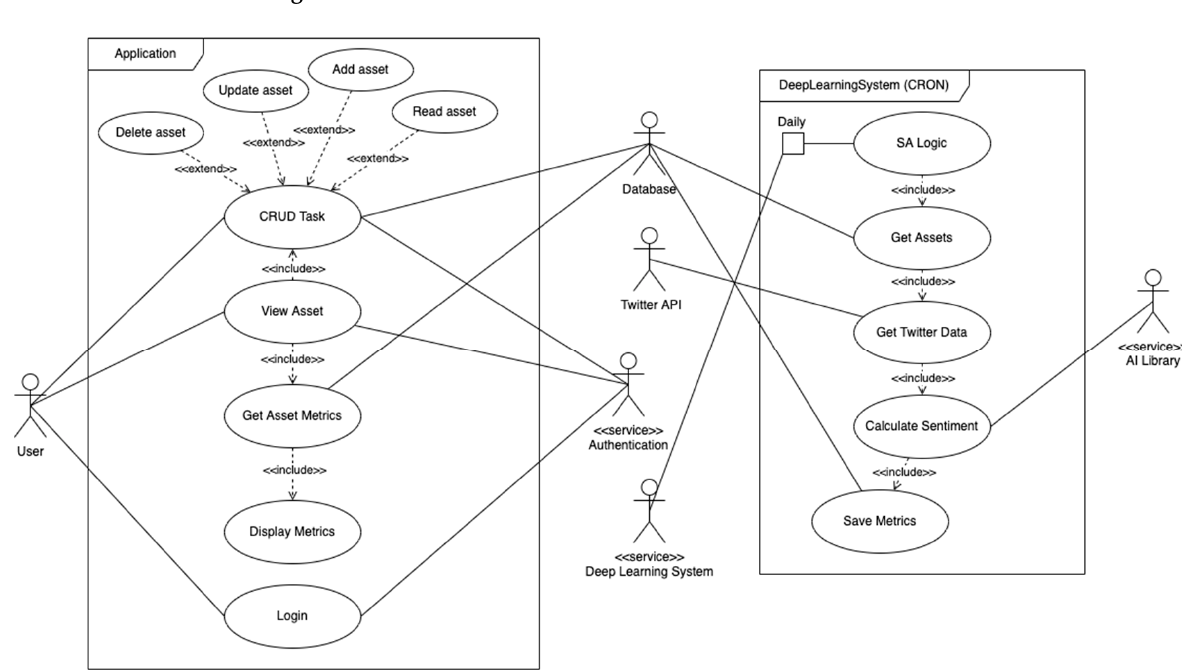
Figure 6. Use Case Diagram. Figure 6. Use Case